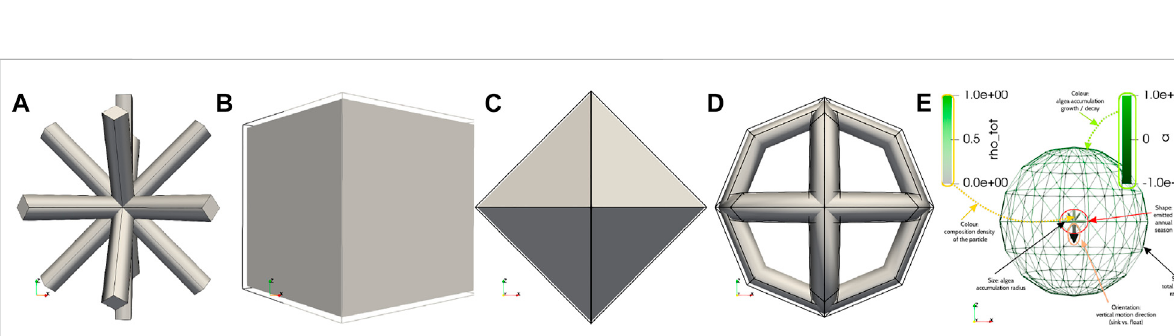
represents the season indicator at the release time of the particle, mapping the glyphs in Figure 14 to the individual seasons. This core glyph is then modulated in its green intensity with the particle density ρ and in its scale by the bio fi lm thickness r bio . The overall particle, as an accumulation of plastic and bio fi lm, is represented with a spherical shell, that is scaled by the overall particle radius r . The shell is presented with its wireframe line structure to allow for the visibility of the core glyph in an unobstructed manner. The colour intensity of the shell is modulated by the overall algae concentration a in a diverging green-tone colour scale, graded in the luminance channel, which semantically does not con fl ict with the core intensity as ρ (cid:4) a . At last, the vertical motion is indicated in its orientation by a static arrow attached to the core, although this can alternatively be encoded in the core ’ s illumination equation in cases where the arrow glyph is allocated for a different attribute. The full semantic encoding of the particle glyph is illustrated in Figure 14E.